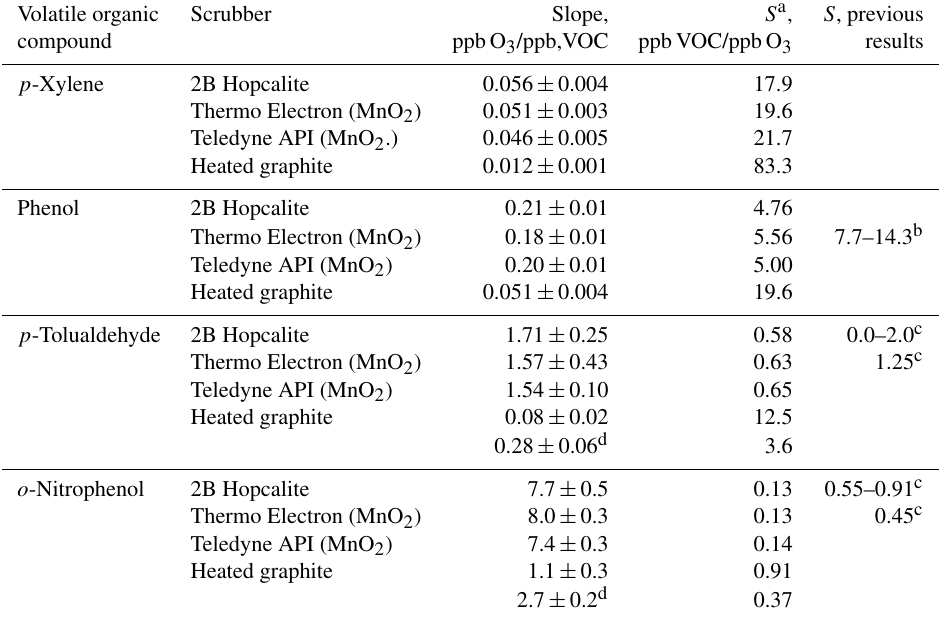
Table 2. Summary of results from tests of VOC interferences in dry air. Volatile organic Scrubber Slope, S a , S , previous compound ppbO 3 /ppb,VOC ppbVOC/ppbO 3 results p -Xylene 2B Hopcalite Thermo Electron (MnO 2